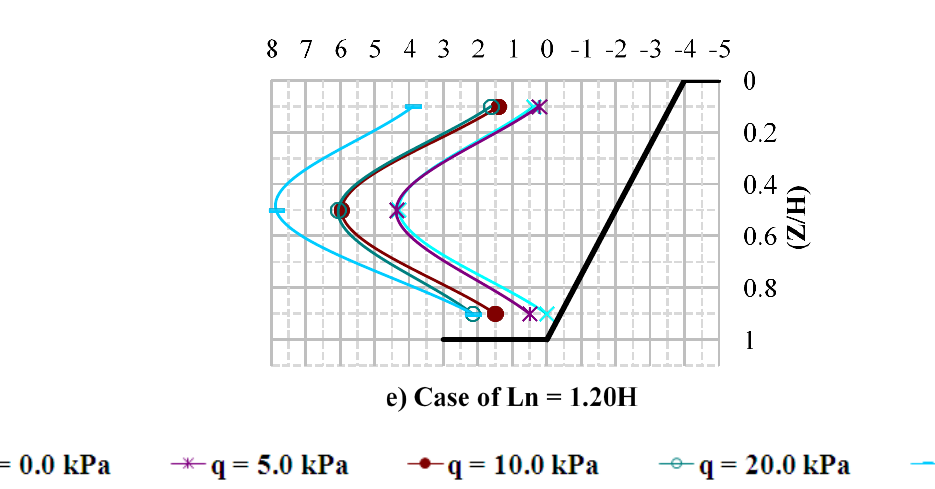
Figure 10. Distribution of the slope face horizontal stresses at different nail lengths. Figure 11 represents the influence of the nail length on the horizontal stresses at the slope face at the middle of the slope without surcharge loading and at a footing pressure of 30.0 kPa. It is clear from the figure that the percentage increases in horizontal stresses at the slope face range from 19.2% to 30.3% with the inclusion of nails and with the in- crease in nail length. This may be due to small, lateral displacements of the slope face with longer nails, producing larger horizontal stresses at the slope face.